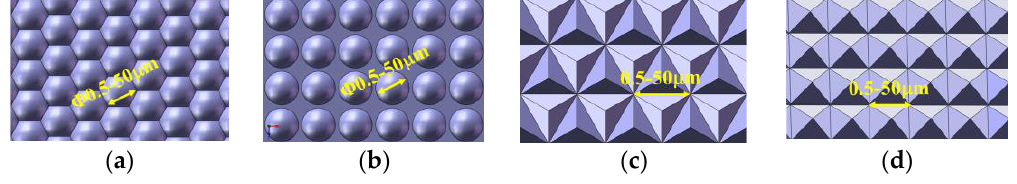
Figure 4. Element shapes of the ChG freeform optics: ( a ) adjacent microlens arrays, ( b ) distributed microlens arrays, ( c ) triangular pyramid arrays, and ( d ) rectangular pyramid arrays [ 34 ].